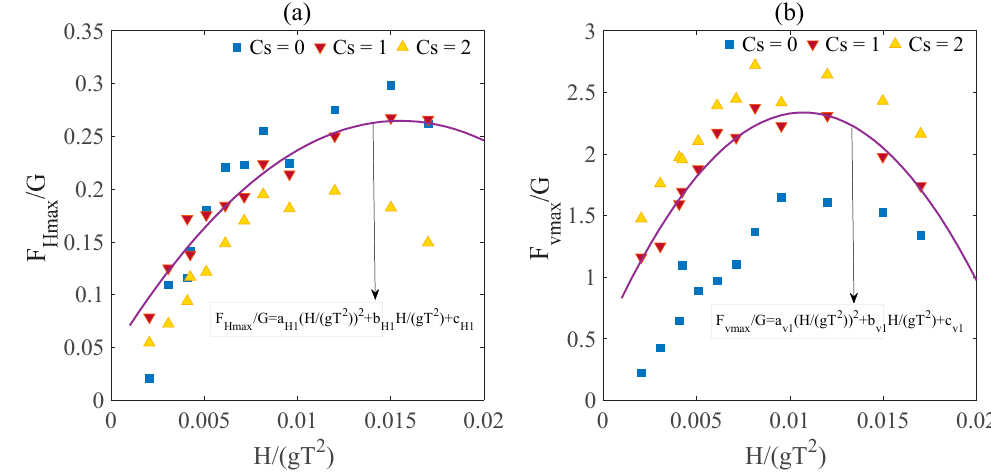
Figure 14. Distributions of maximum wave forces divide gravitational force ( F / G ) versus H/ ( gT 2 ) under three different submerged coefficients ( C s ). ( a ) Maximum horizontal force divides gravitational force ( F H max / G ) and ( b ) Maximum uplift force divides gravitational force ( F v max / G ). Here, the formula of a fitted curve is given when i = 1.